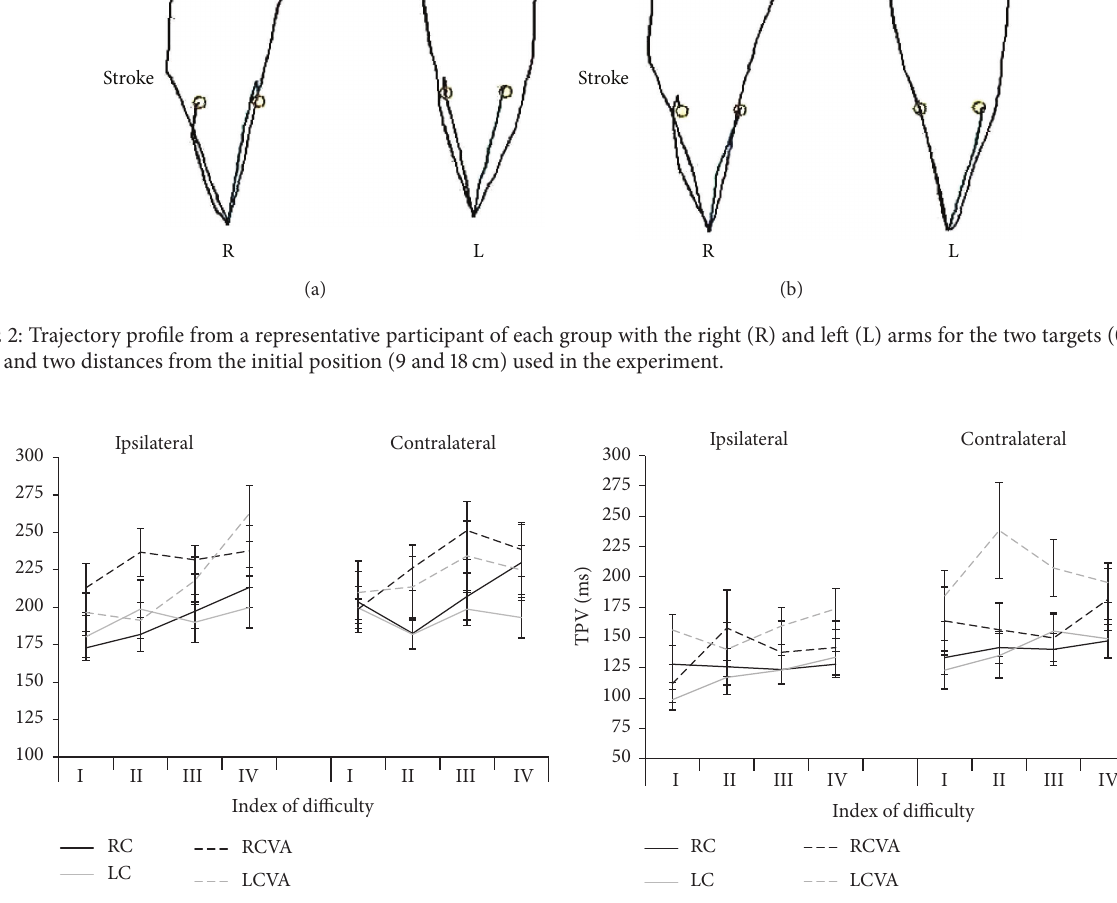
versus LCVA ( 𝐹 2.5,45.2 = 9.39; 𝑃 < 0.0001 ), indicating that